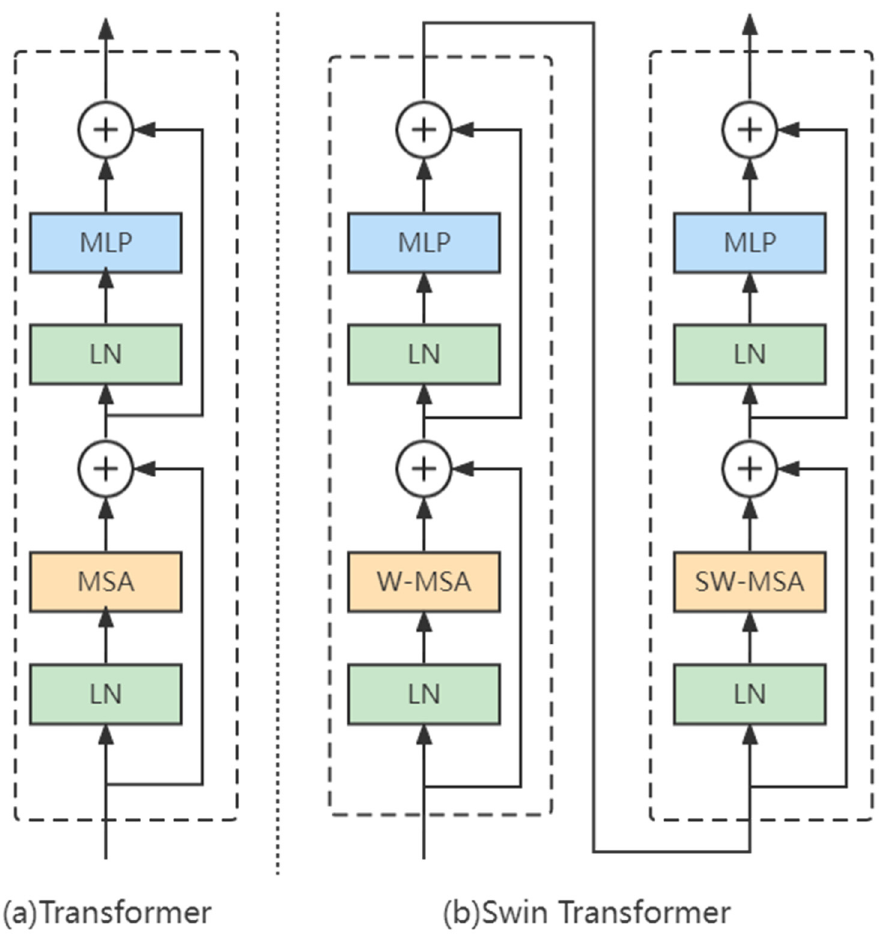
Figure 6. Structure diagram of ( a ) Transformer and ( b ) Swin Transformer. LN stands for Layer Normalization, MSA stands for Multi-head Self-Attention Mechanism, and MLP stands for Multi-Layer Perceptron.